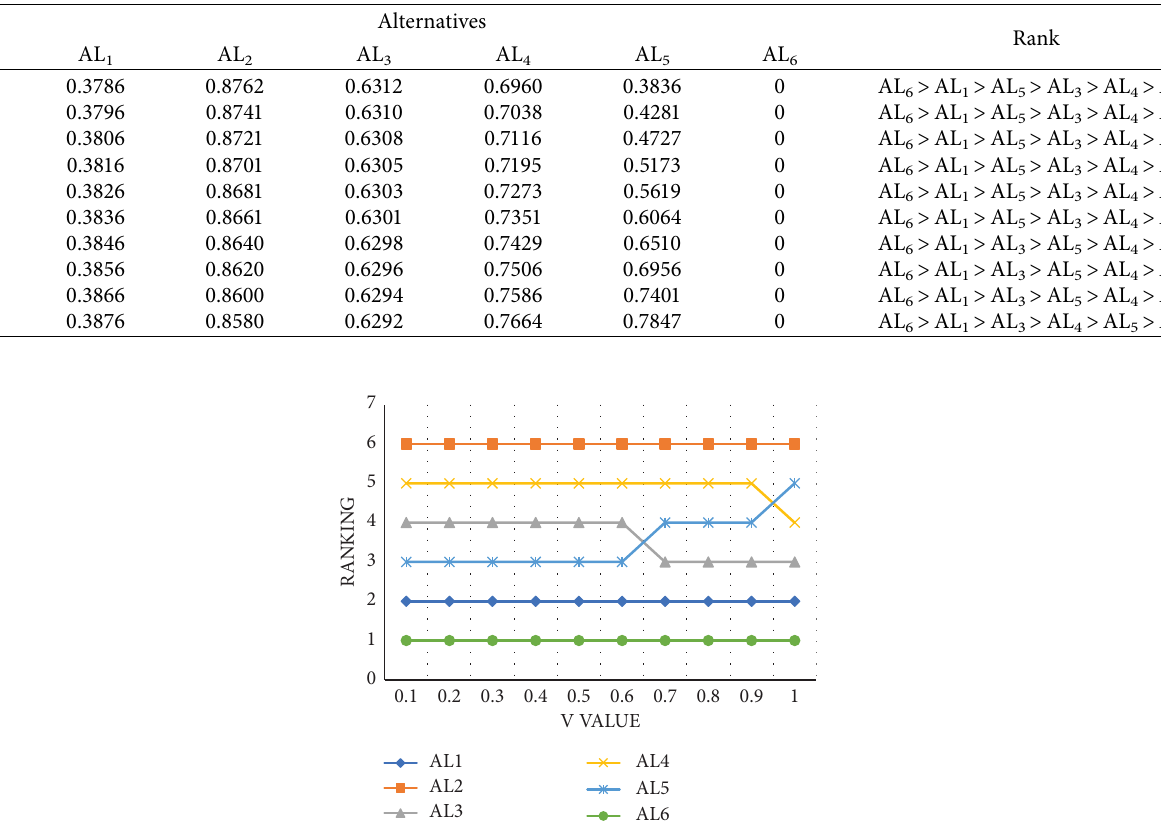
Table 16: Ranking of alternatives in sensitivity runs when group utility ( v ) varies from 0.1 to 1.0.